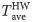
The relationships between RD and heat wave characteristics: (a-c) OHW, (d-f) DHW, and (g-i) TaveHW. Controlled variables are chosen as their first (Q1), second (Q2), and third quartile (Q3).